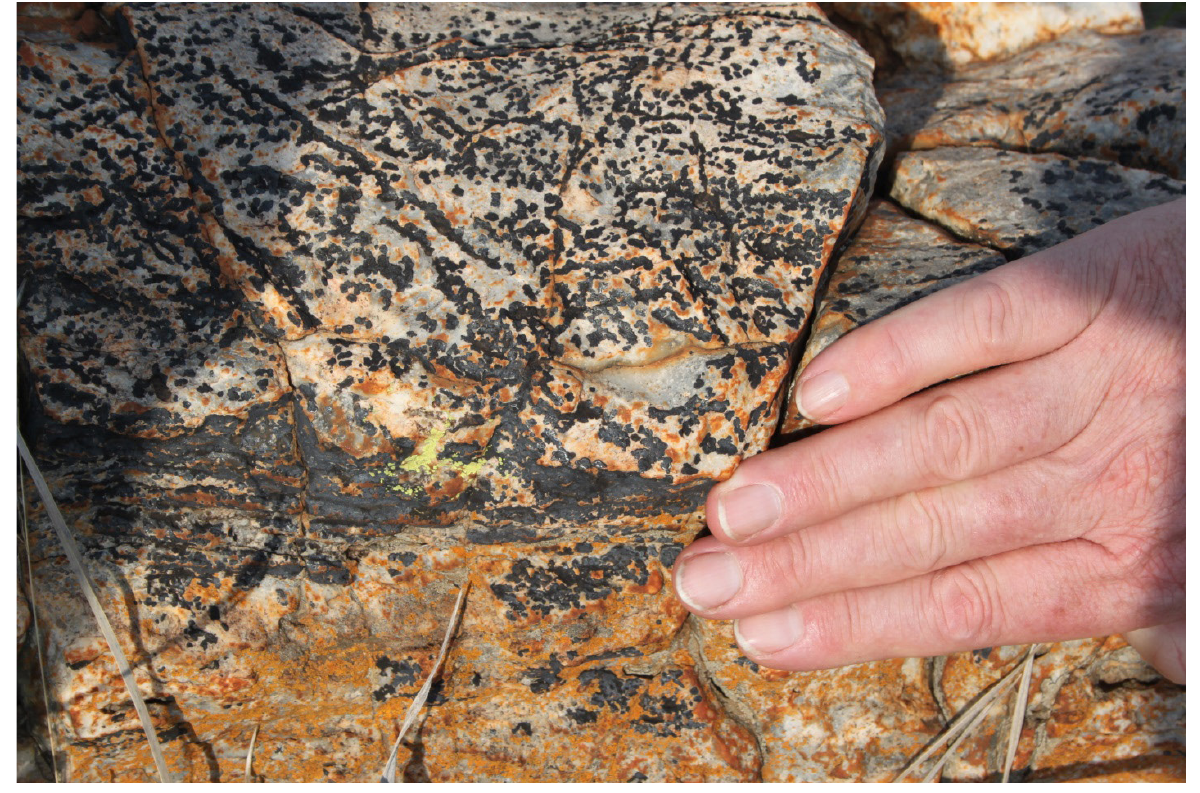
Figure 4: A chert rock at Kromdraai, showing the distribution of spots of manganese oxy-hydroxide, which may relate to former growth of lichen which dispersed in spots. Note the presence of actively growing green lichen, which in this instance may be very young compared with earlier phases of lichen growth and deposition of manganese oxy-hydroxide. Photograph: Jean-Baptiste 3 South African Journal of Science http://www.sajs.co.za